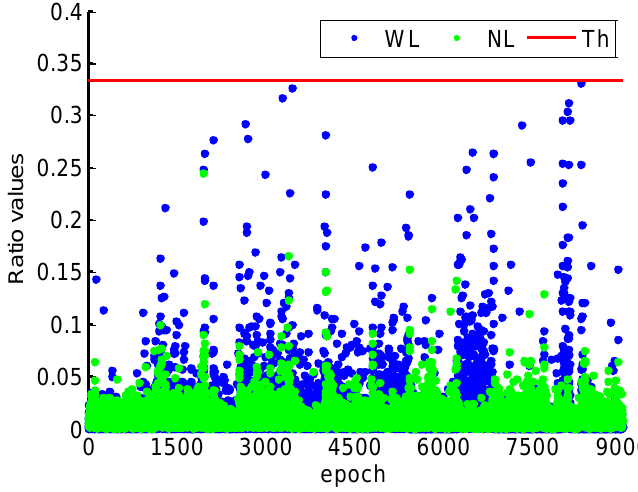
Figure 15. Ratio values of WL and NL.